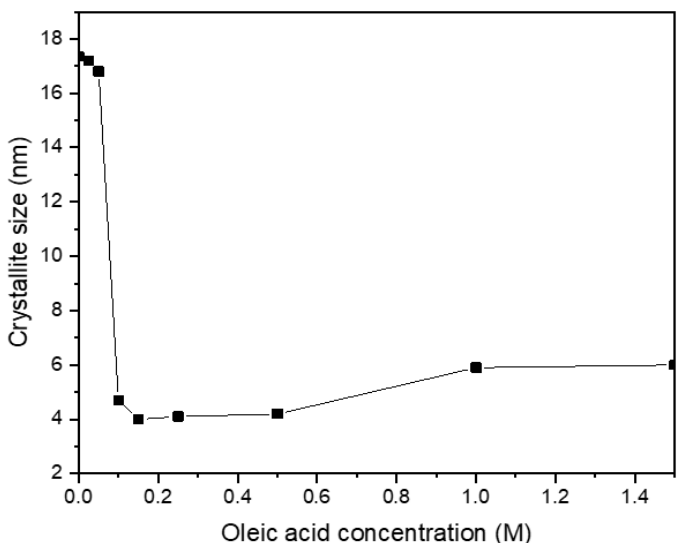
Figure 10. The average crystallite size as a function of oleic acid concentration calculated by using the Scherrer formula.